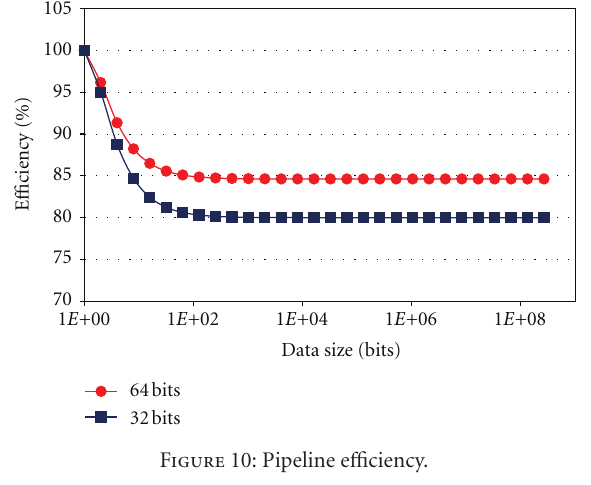
Figure 11: Addition/subtraction execution time (64-bit).